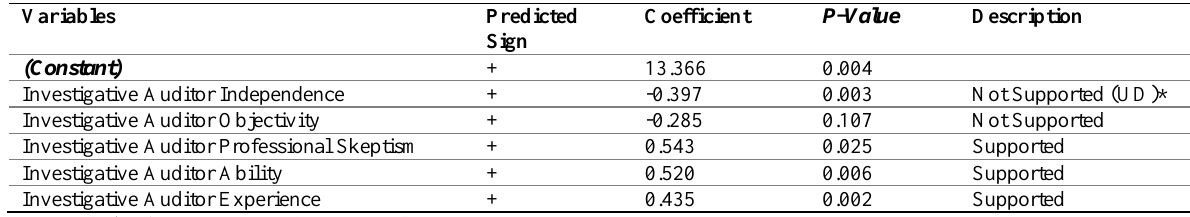
Table 2: Results of Multiple Linier Regression